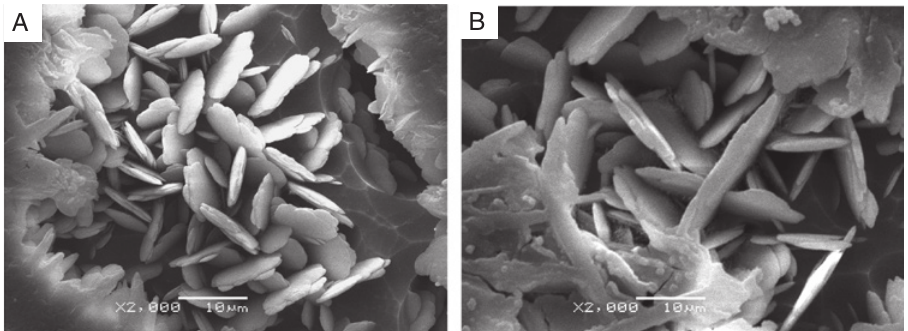
Figure 4: SEM micrographs of sample with average grain size of 100 μ m. (A) Parallel to the press axis and (B) perpendicular to the press